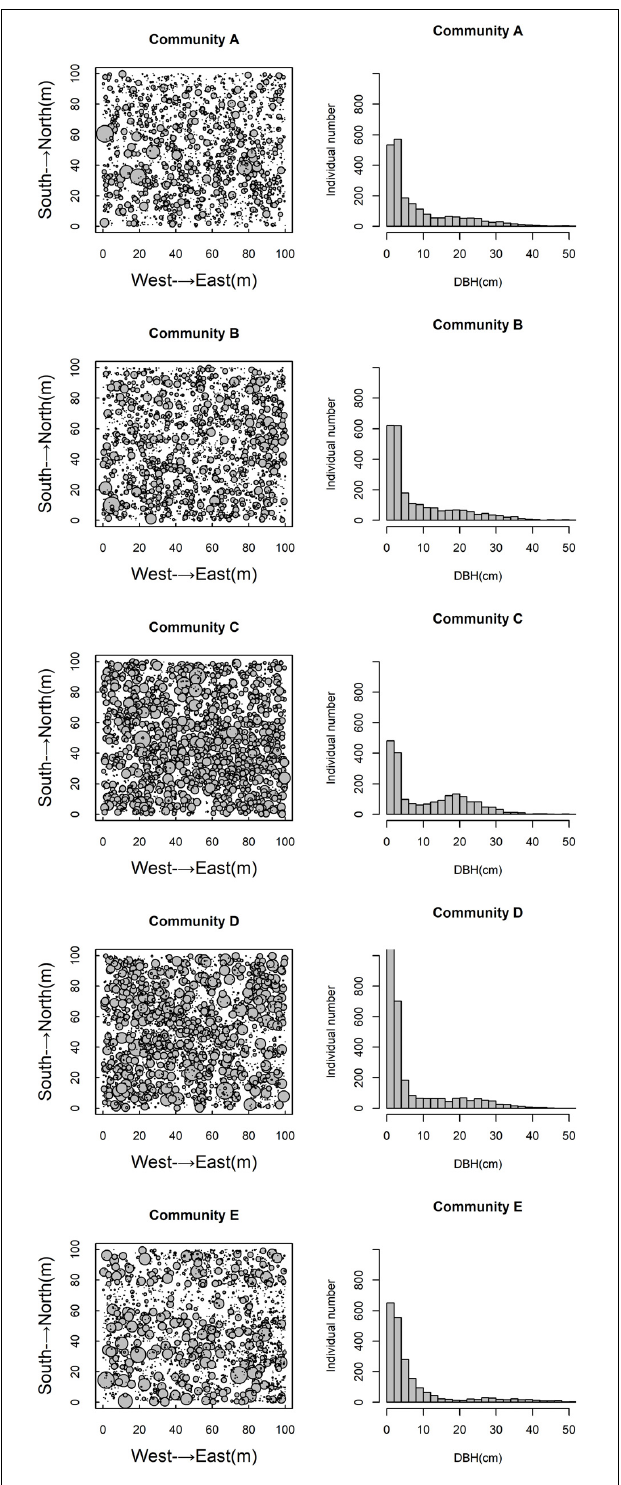
FIGURE 1 | Spatial scatter plots and DBH plots of woody plants in different communities. A, B, C, D, and E were the Quercus variabilis community, Quercus glandulifera var. brevipetiolata community, Mixed broadleaf-conifer community, Quercus aliena var. acutiserrata community, and Miscellaneous wood community, respectively.